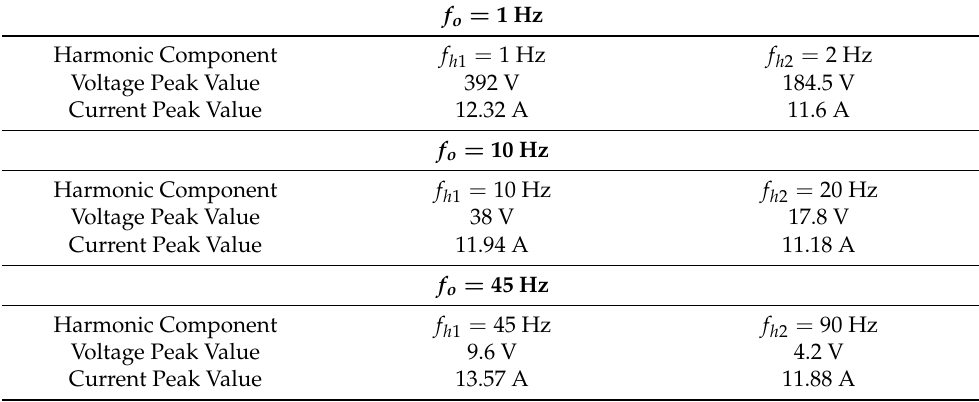
Table 2. Two most influential harmonic components of MMC submodule capacitor quantities. f o = 1 Hz Harmonic Component f h 1 = 1